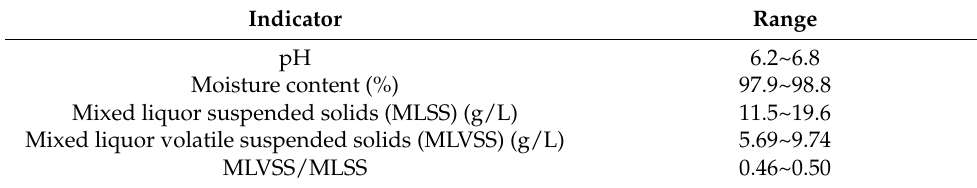
Table 1. Basic properties of concentrated sludge.